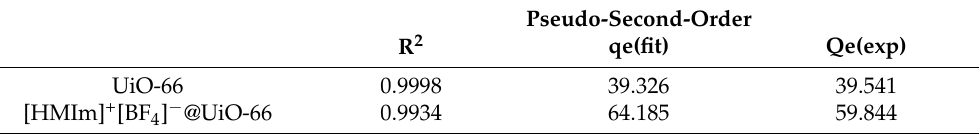
Table 1. The kinetic parameters of pseudo − second − order model.